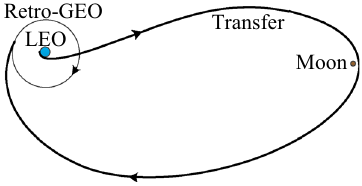
Figure 1. The transfer from LEO to the retrograde-GEO via lunar